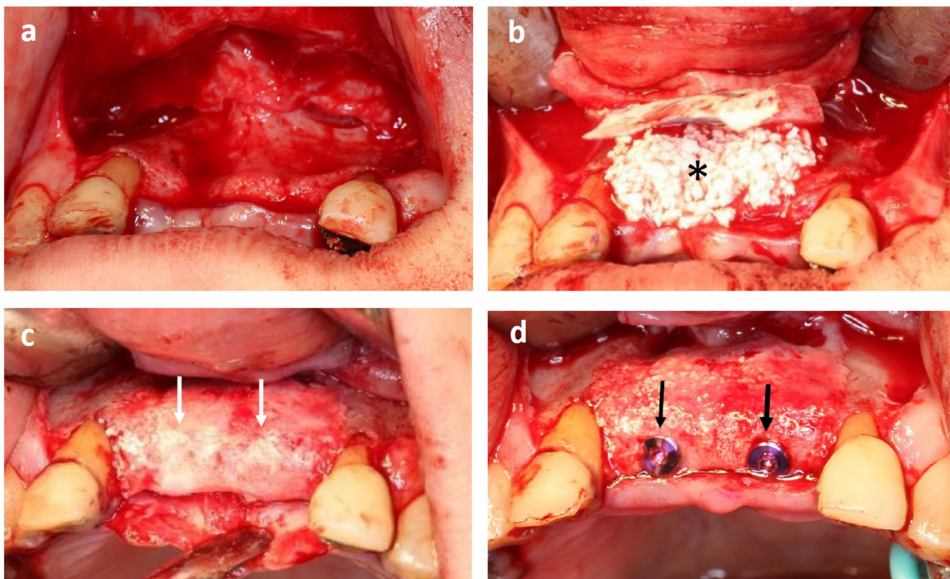
Figure 5. A representative case of alveolar ridge augmentation. ( a ) Elevated mucoperiosteal flap. Note the thin alveolar bone. ( b ) Tissue-engineered bone put onto the buccal side of the alveolar bone. (* indicates the tissue-engineered bone). ( c ) Four months after transplantation (white arrows indicate regenerated bone). ( d ) Dental implants were installed into the regenerated bone (black